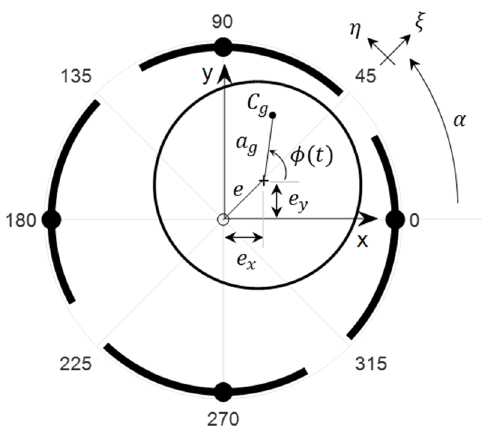
Figure 3. Schematic representation of the four-shoes TPJB. The global and local coordinates are given in the x-y and ξ - η directions, respectively.